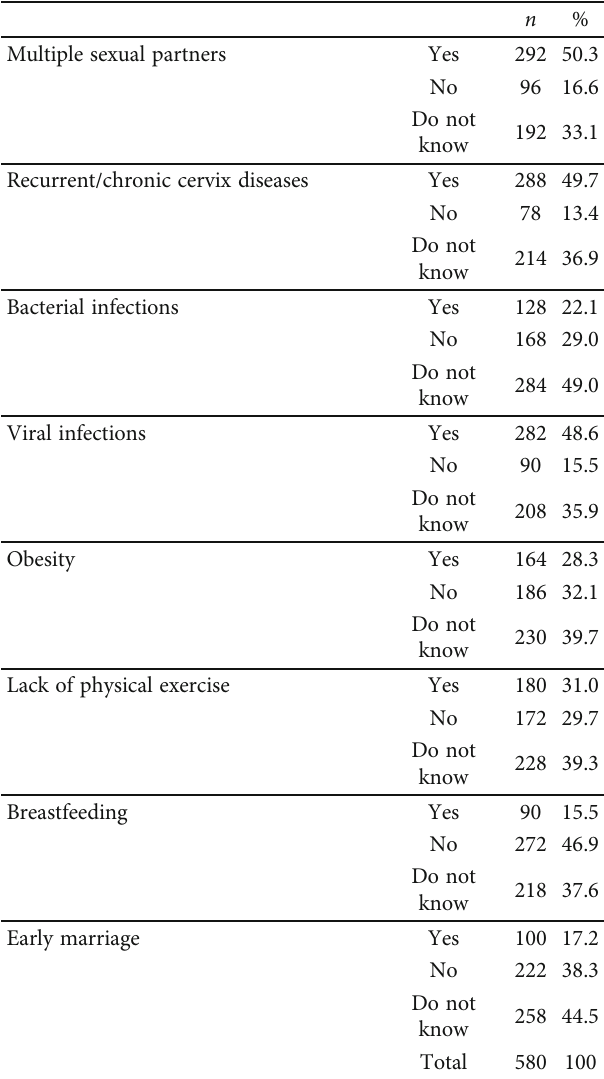
Table 4: Responses of the participants regarding the knowledge and awareness of the risk factors of cervical cancer ( n = 580